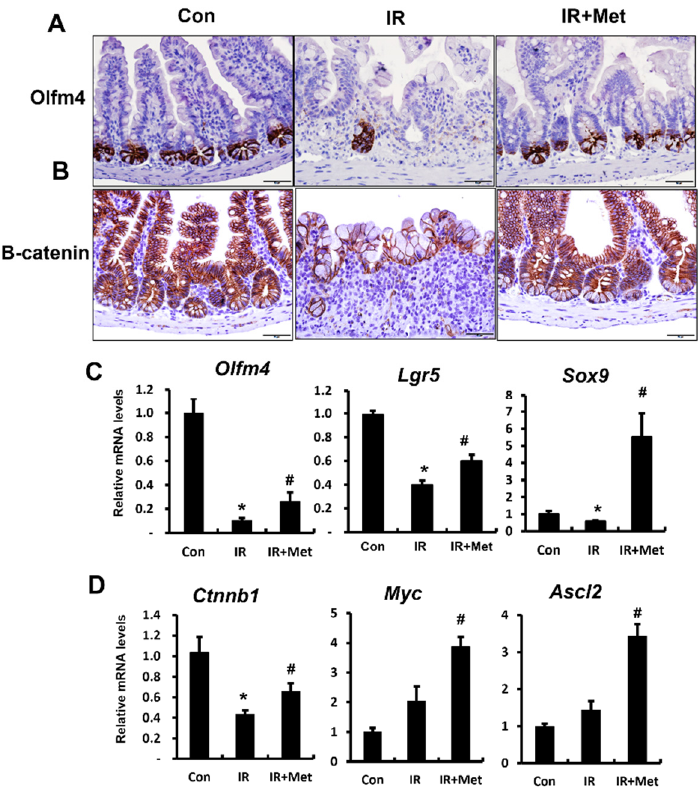
Figure 4. Metformin promoted stem cell properties with Wnt/b-catenin pathway activation in radiation damage. Immunohistochemistry of ( A ) Olfactomedin4 (Olfm4) and ( B ) β -catenin in the small intestine of control (Con), irradiated (IR), and metformin-treated IR (IR + Met) mice. Bar = 50 μ m. ( C ) The mRNA levels of stem cell property markers, such as Olfm4, leucine-rich repeat containing G protein-coupled receptor 5 (Lgr5) , and SRY-box transcription factor 9 (Sox9) in Con, IR, and IR + Met groups. ( D ) The mRNA levels of β -catenin (Ctnnb1) and Wnt/b-catenin-related genes (Myc and Achaete-scute complex homolog 2; Ascl2 ) in the Con, IR, and IR + Met groups, as determined by real-time RT-PCR. Levels of mRNA expression are shown as the fold induction relative to the expression in Con group. Data are presented as the mean ± standard error of the mean; n = 6 mice per group. * p < 0.05 compared to the Con group; # p < 0.05 compared to the IR group.